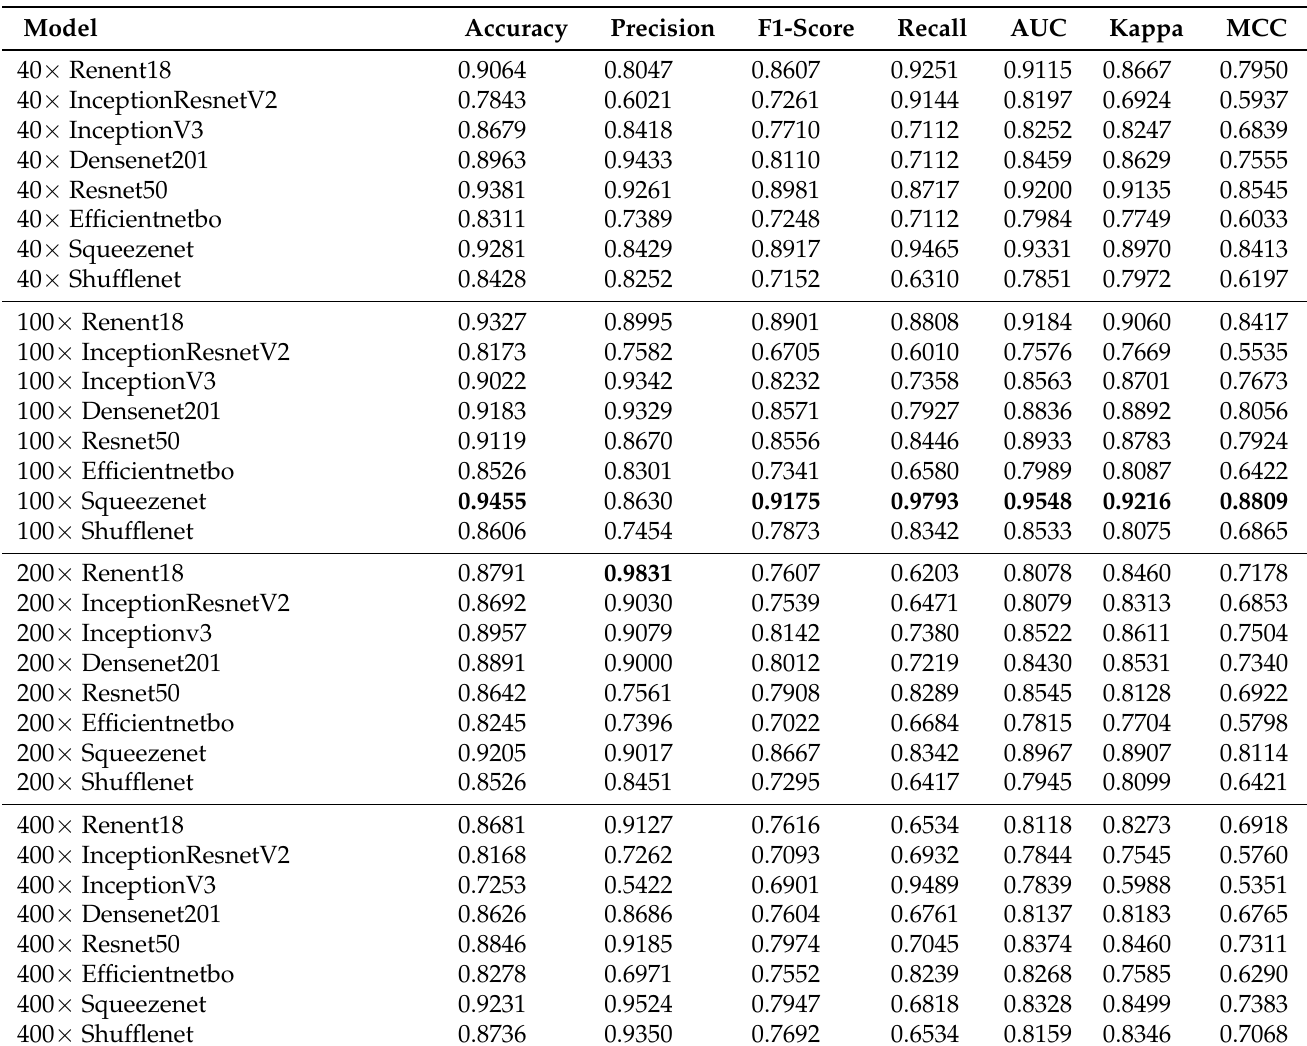
Table 7. Binary (benign vs. malignant) classifier performance: comprehensive table of metrics for classifying various magnification levels of histopathological images using baseline CNN models with pre-trained weight from ImageNet (no fine-tuning of weights on the BreakHis